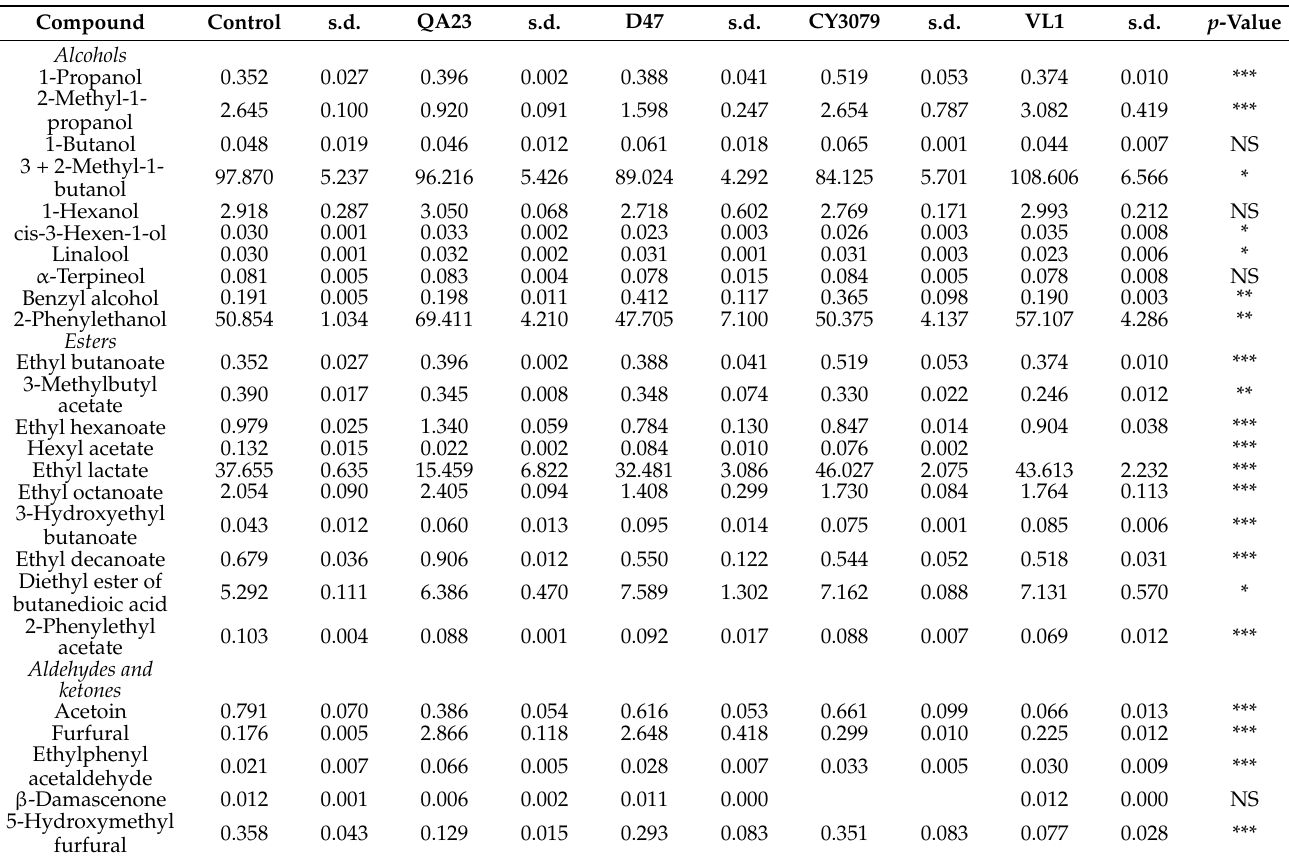
Table 1. Content (mg L − 1 ) of volatile compounds in “Fiano” white wines obtained by using four selected yeast strains and fermenting the must in oak barrels. The compounds are grouped according to their chemical composition. Compound